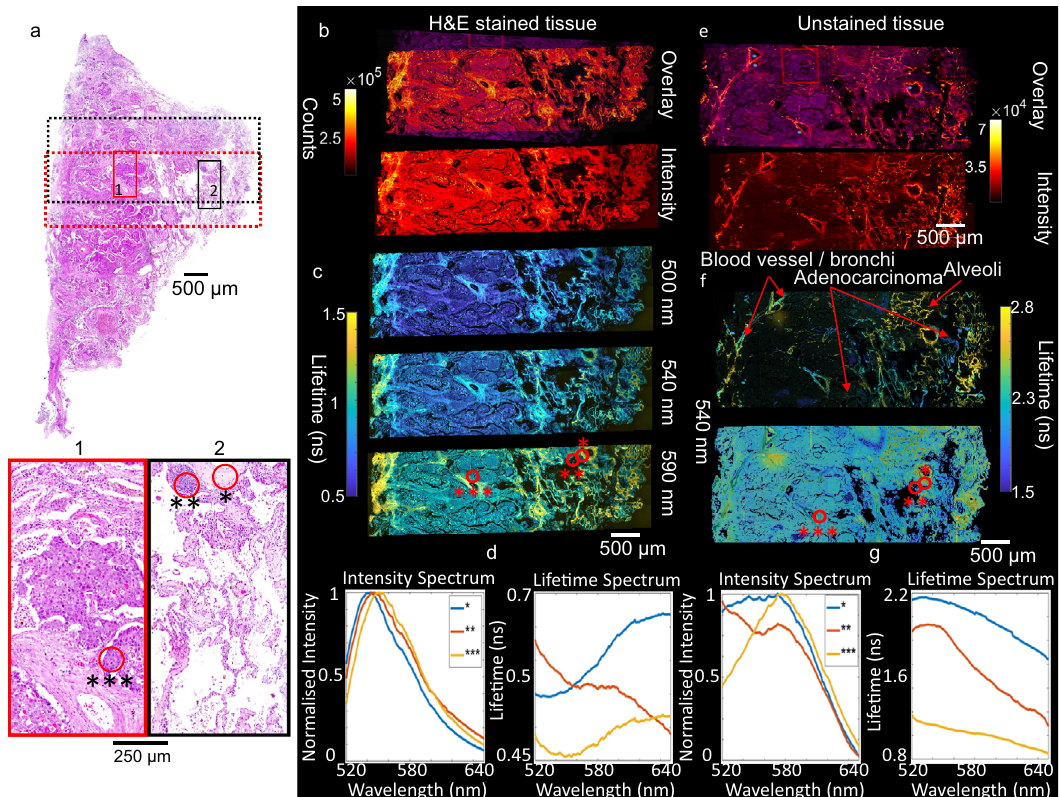
Fig. 4 Full spectral fl uorescence lifetime imaging of a histology slice of lung tissue. a Haemotoxylin and Eosin (H&E) stained histology image of lung tissue with increasing cancerous (adenocarcinoma) tissue (from right to left). Highlighted areas show cancerous (1) and visibly healthier (2) regions. Dashed areas indicate the regions imaged for the stained (red) and the equivalent unstained (black) slice. Three regions of interest are highlighted. b Intensity based imaging of a stained histology slice both with and without overlay of the histology image. Tiled images consist of 4 rows of 12, 256 × 256 pixel images with a fi eld of view of 600 × 600 μ m each which were taken with 1 ms exposure time per pixel. A series of images were taken and subsequently combined to form a composite image showing the complete area (~6 × 2 mm). c Corresponding lifetime images at different wavelengths. d Mean spectral intensity (left) and spectral lifetime (right) for the three regions of interest. e Intensity imaging of an unstained slice both with (top) and without (bottom) overlay with the histology image. Images consist of 5 rows of 12, 256 × 256 pixel images, each ~600 × 600 µ m, 1 ms exposure time per pixel. f Lifetime image at 540 nm displayed with intensity-based color saturation and an inverted color saturation. g Mean spectral intensity and spectral lifetime or the three regions of interest. The data shown is from a single sample per slice with 60 FS-FLIM images per slice, taken once each, one histology image was